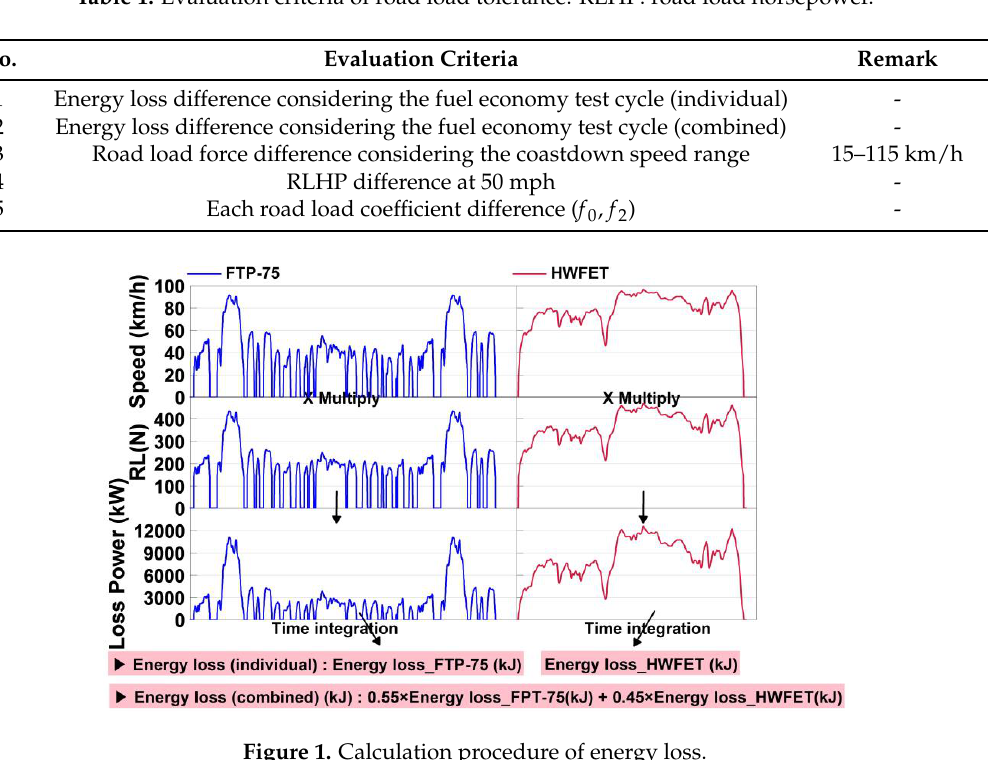
Table 1. Evaluation criteria of road load tolerance. RLHP: road load horsepower.